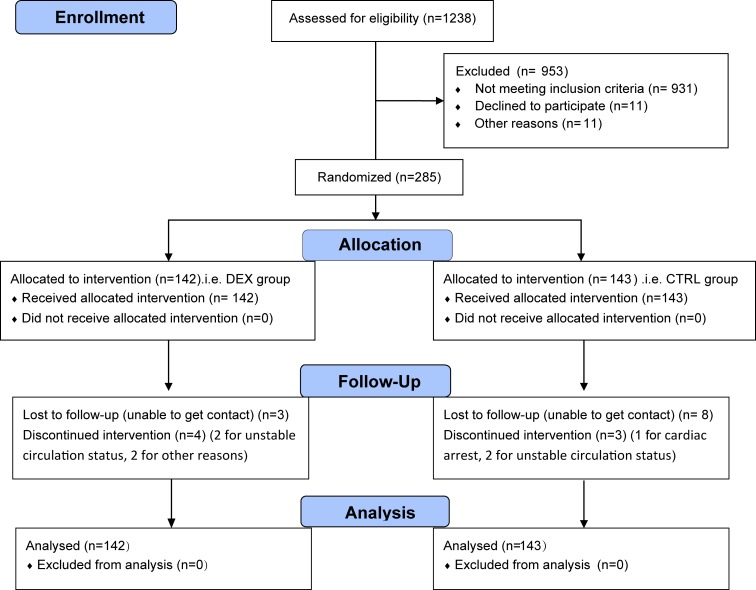
Flow Diagram of the study.DEX, dexmedetomidine; CTRL, control; ITT, Intention-to-Treat.